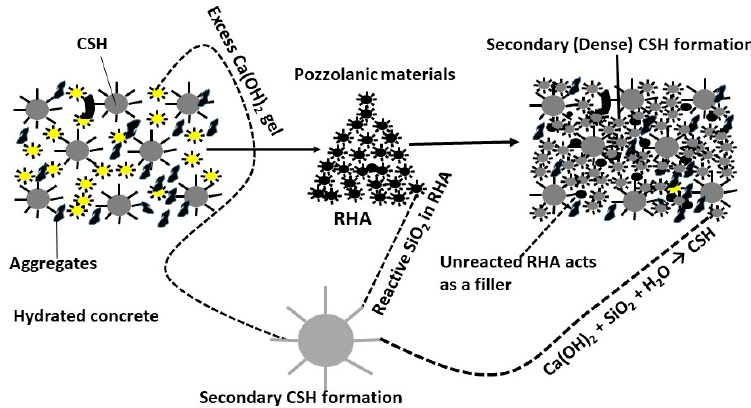
Figure 7. Hydration process for cement with the addition of RHA . Table 5. Chemical composition of SBA .